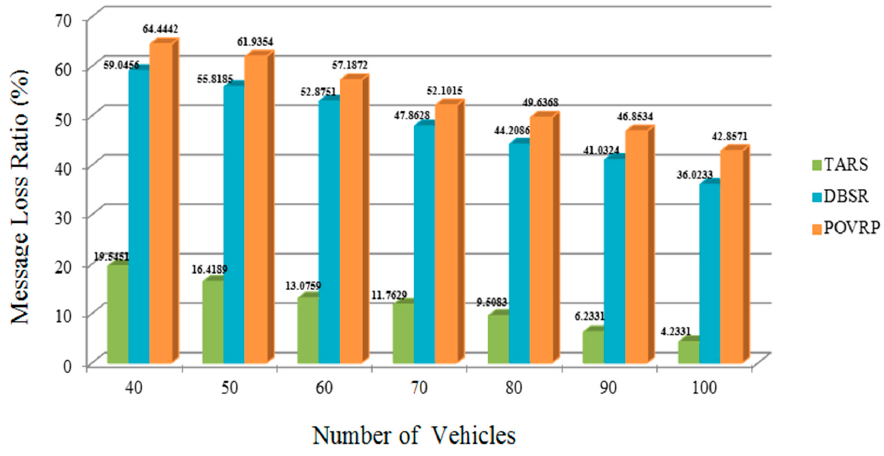
Figure 15. Message Loss Ratio w.r.t. the Varied Vehicle Density in the highway